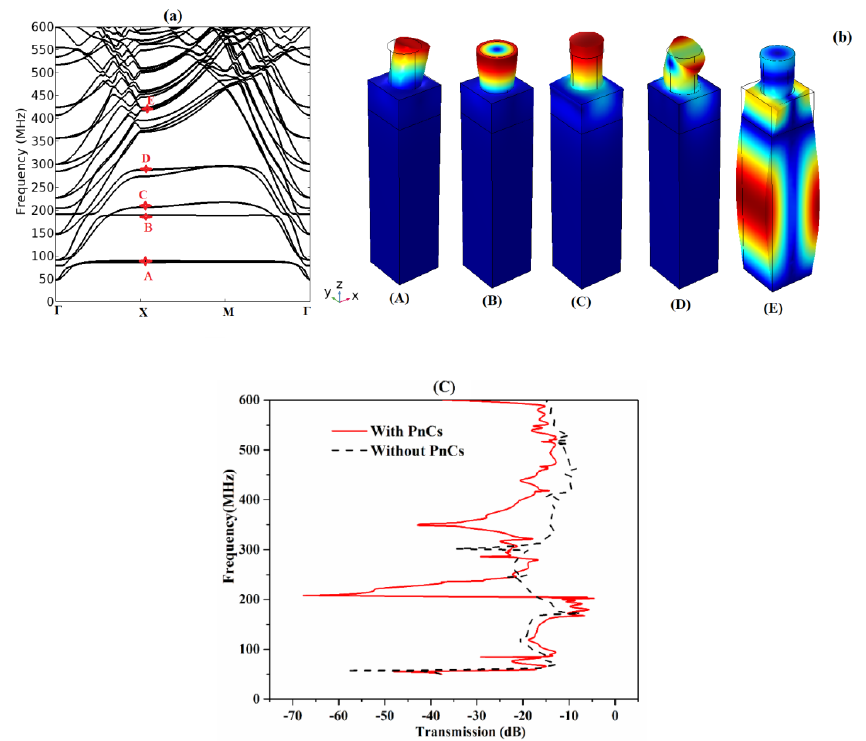
nated by points A, B, C, D, and E. The acoustic branches, passing by A and D, are degen- erated because of the x and y polarization modes appearing at the same frequency.